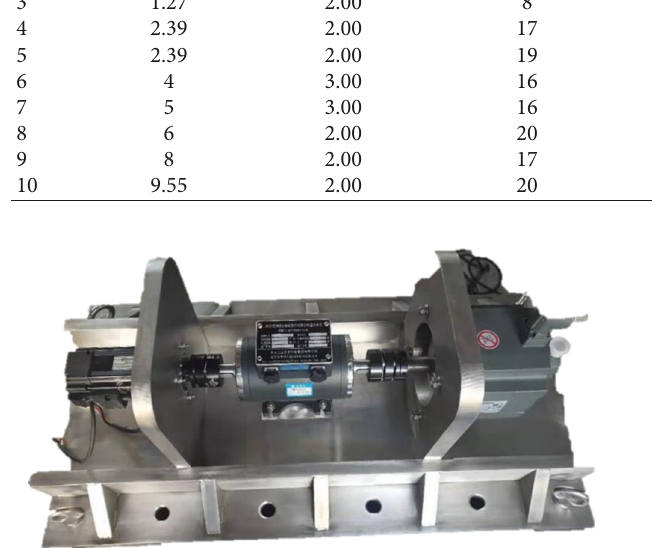
Figure 4: Servo system reliability test